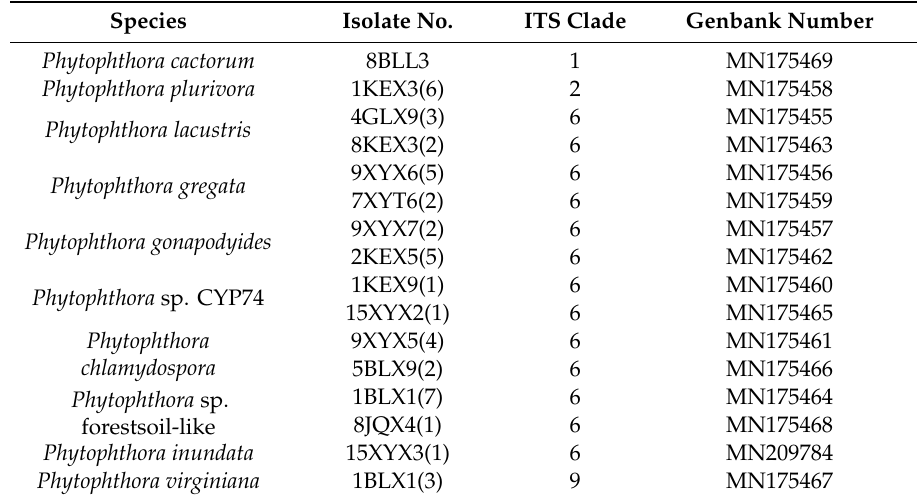
Table 2. GenBank number and rDNA internal transcribed spacer (ITS) clade of 10 Phytophthora species in Xinjiang wild apple